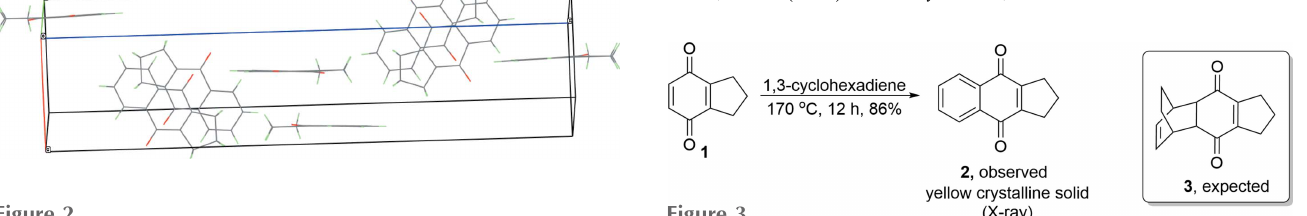
Figure 3 Synthesis scheme for the title compound.